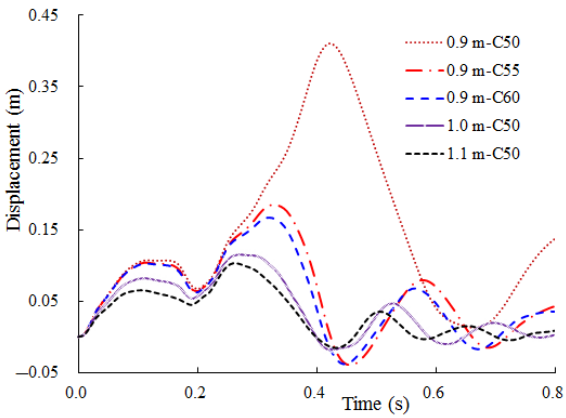
Figure 24. Max displacement time-history of containment.